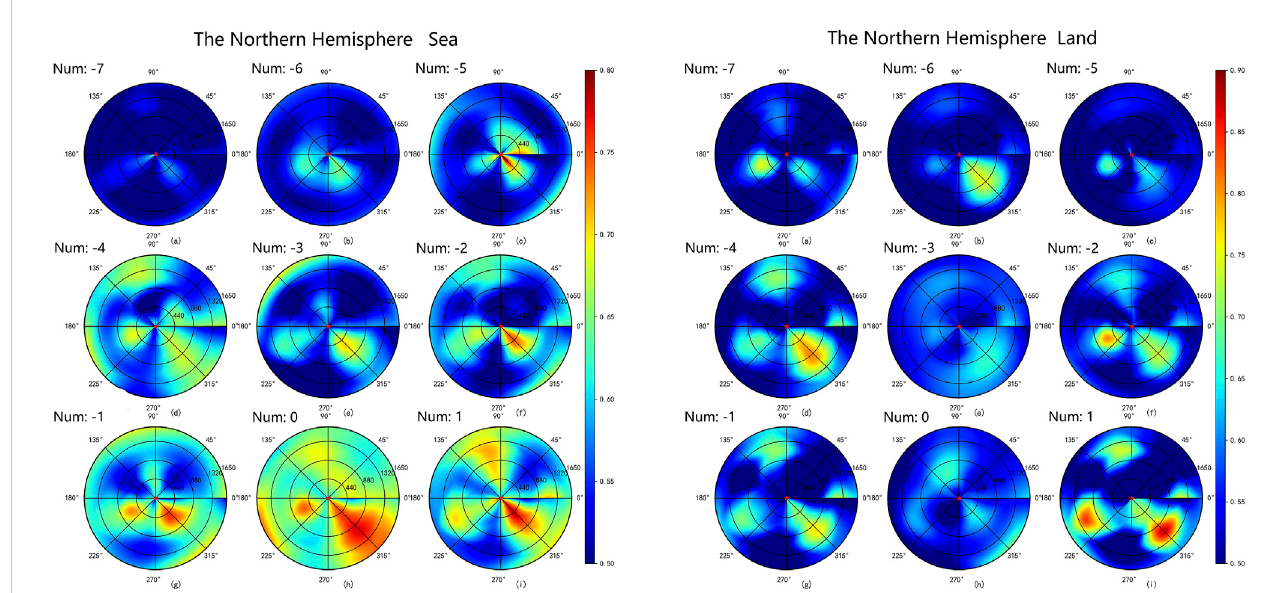
FIGURE 6 Spatial and temporal distribution of pre-seismic disturbances in the ELF frequency band (19.5 – 250 Hz) of the space electric fi eld obtained from sea and land earthquakes of magnitude 6.0 or higher in the Northern Hemisphere. (Num: − 7 to Num: − 1 represents the seventh cycle to the fi rst cycle before the earthquake, Num: 0 is the period of earthquake, Num: 0 is the fi rst period after the earthquake).